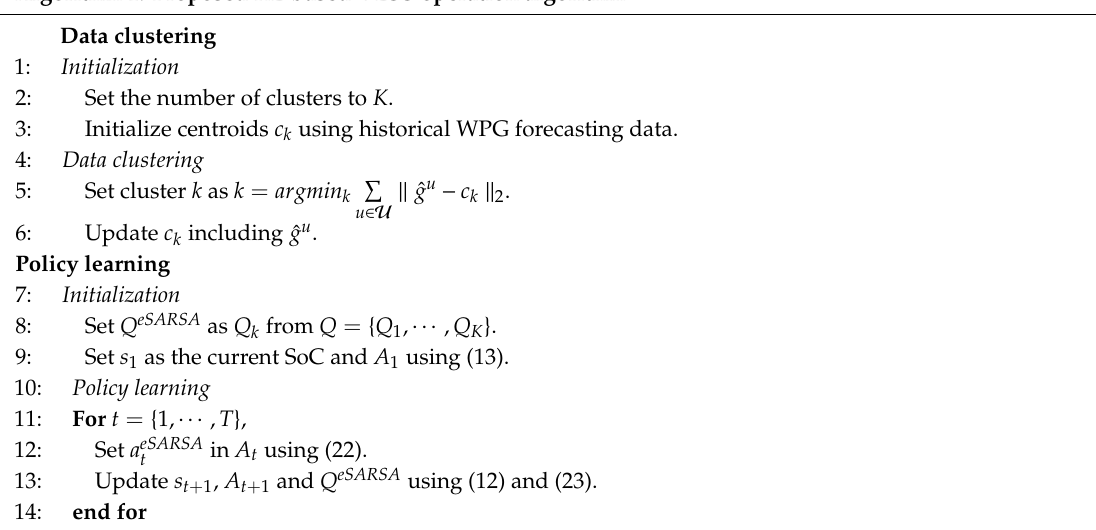
Algorithm 1. Proposed RL-based VESS operation algorithm Data